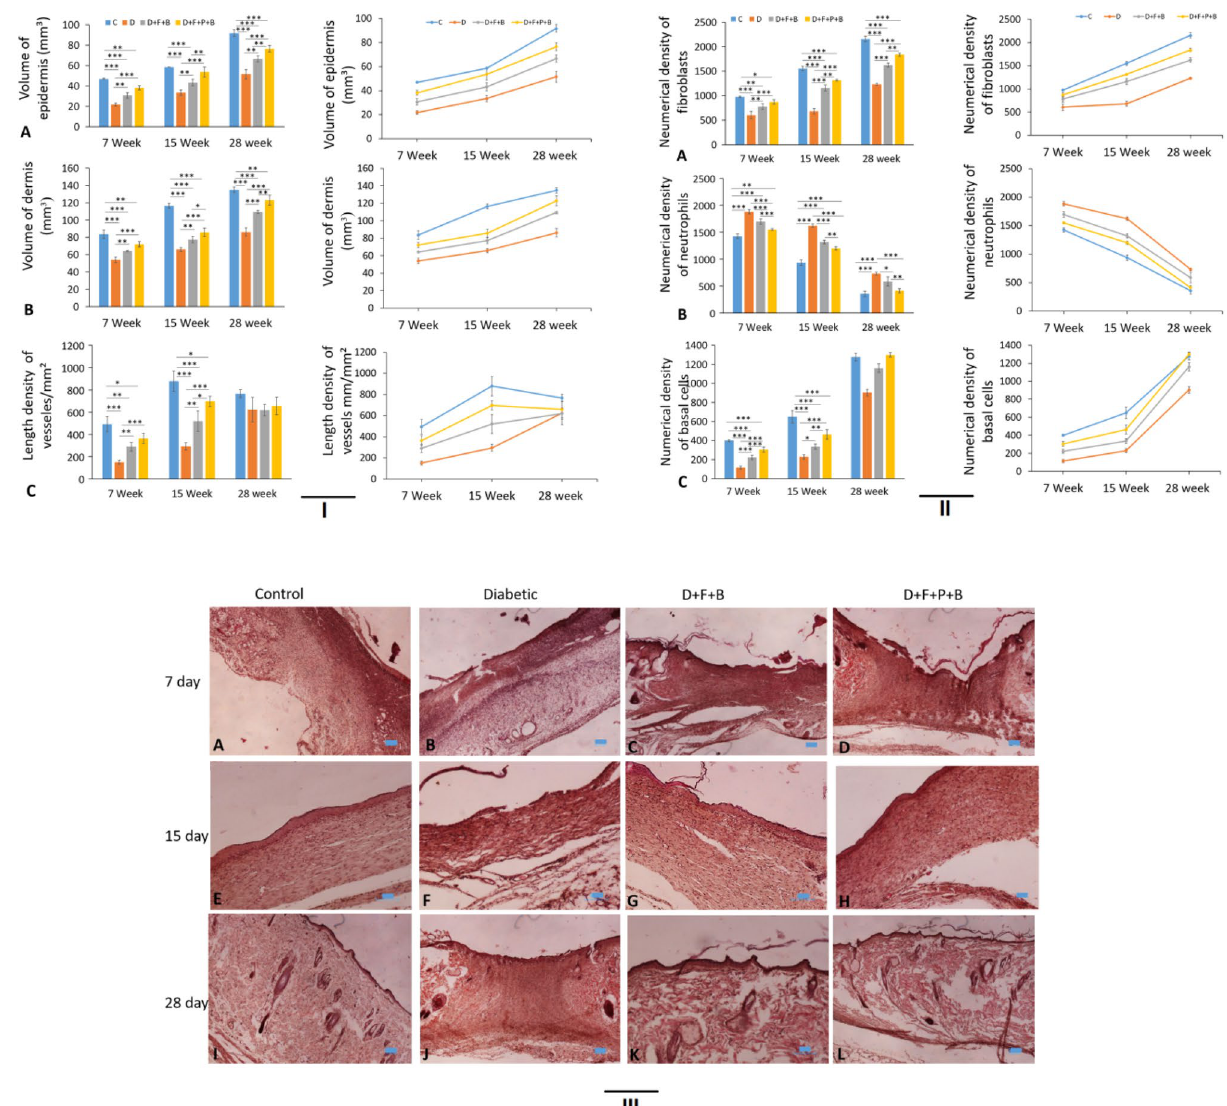
Figure 8. ( I ) Stereological analysis of wound tissue at different time points post-injury. (A–C) Mean ± SD of the total volume of epidermis and dermis at days 7, 5 and 28 post-injury in the wound healing site in the study groups as compared by the one-way ANOVA and LSD; (*P < 0.05, **P < 0.01 and ***P < 0.001). ( II ) Stereological analysis of wound tissue at different time points post-injury. (A–C) Mean ± SD of the number of fibroblasts, neutrophils and basal cells at days 7, 5 and 28 post injury in the wound healing site in the study groups as compared by the ANOVA and LSD; (*P < 0.05, **P < 0.01 and ***P < 0.001) and Repeated Measures. ANOVA, analysis of variance and LSD, least significant difference; C; D; D + F + B; D + F + B + P. ( III , A–L) Micrographs of a wound healing area following injury in different groups at 7, 15, and 28 days in the study groups. H&E staining. Scale bar = 10